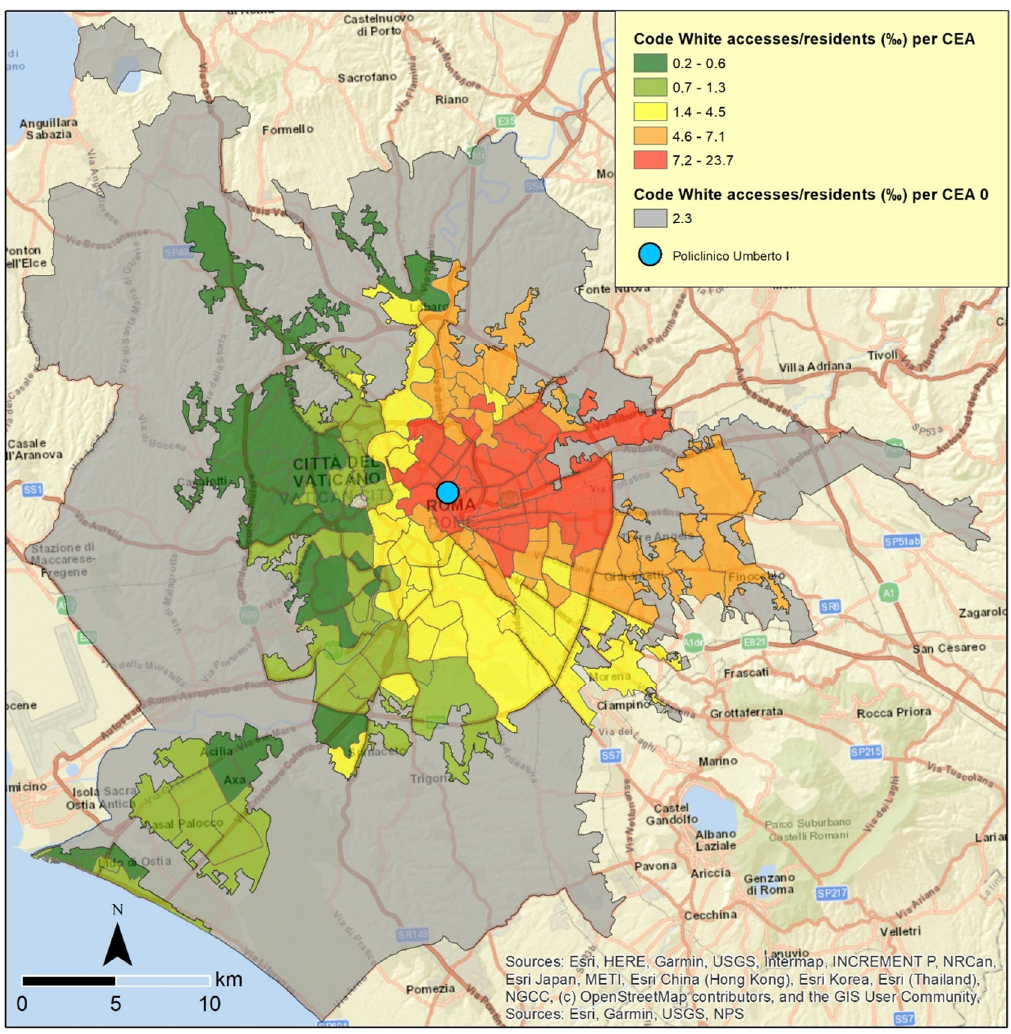
Figure 7. Accesses in code white recorded by the Policlinico Umberto I emergency room in relation to the number of residents, with data aggregated on the basis of census areas. Source: authors’ elaboration.